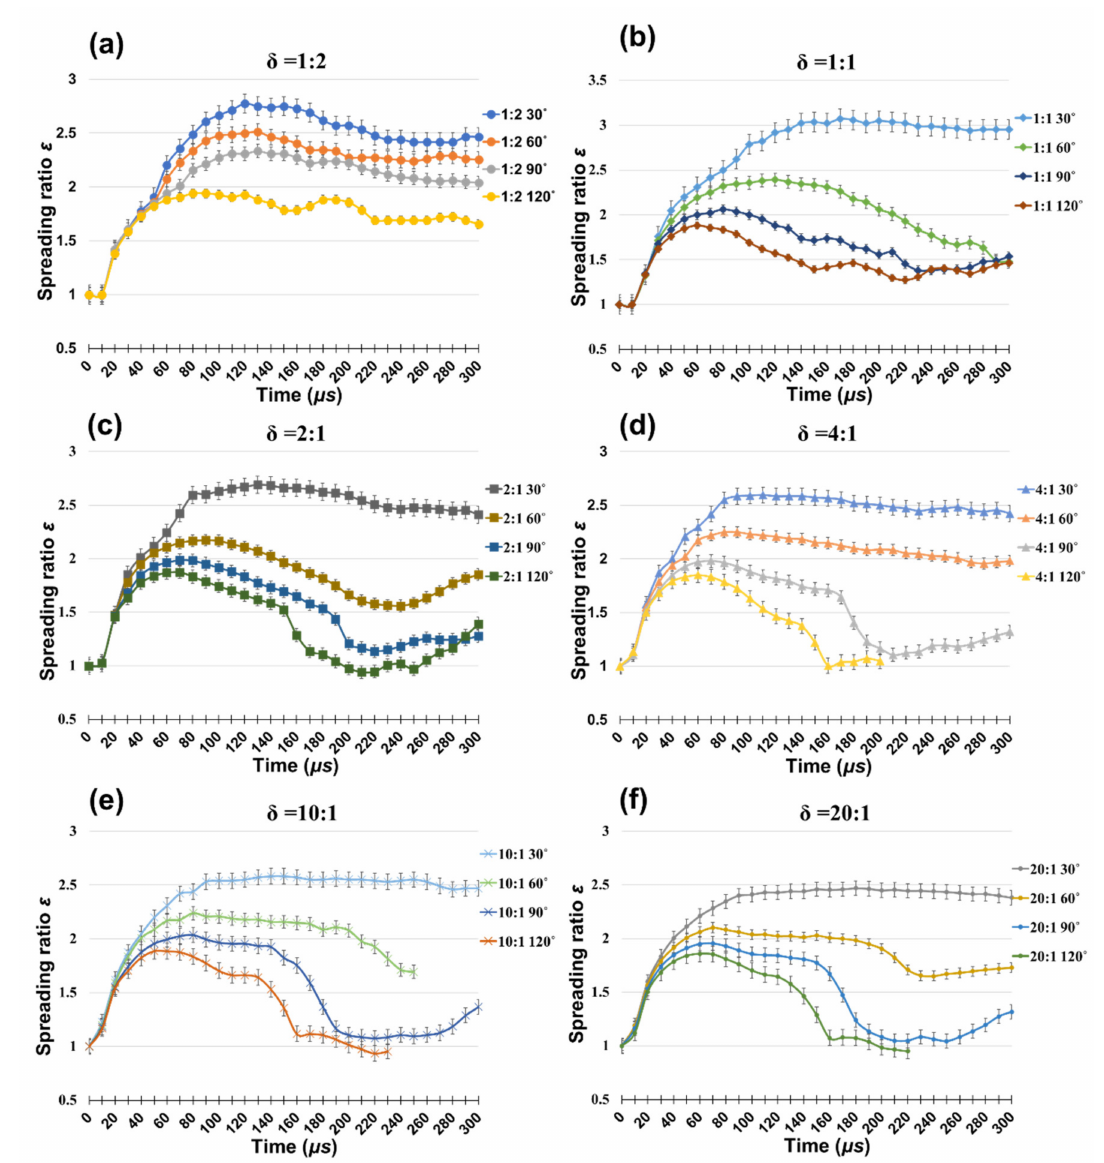
Figure 7. The curves of spreading ratio with time at contact angle of 30 ◦ , 60 ◦ , 90 ◦ , 120 ◦ , under different ratios of droplet diameter to powder particle diameter, respectively. The contact angles were used to define the wettability of powder materials, which covers a range of contact angles for the most common